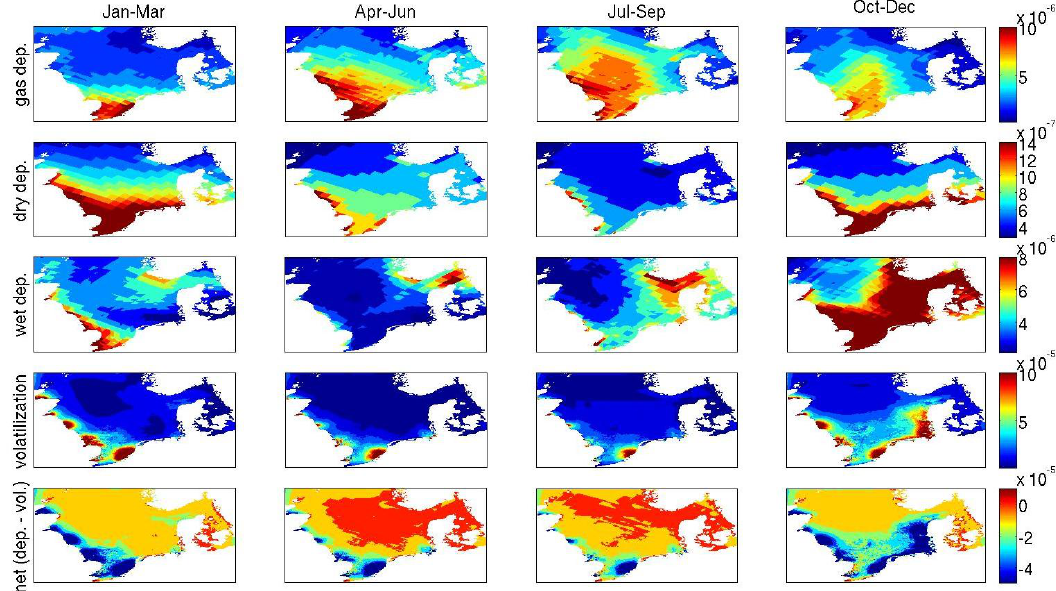
Figure 8. Distributions of quarterly (3 month) averaged rates of gas deposition ( top row ), dry deposition ( 2nd row ), wet deposition ( 3rd row ), volatilization ( 4th row ), and net air-sea exchange ( bottom row ) for PCB 153 in 1996. Rates are in (ng∙m −2 ∙s −1 ). Note: colorbar scales shown on 3rd column panels are used in connection with the left 3 panels. Note the change in scales for autumn (right figures), which are reduced relative to winter, spring and summer. Scales vary from row to